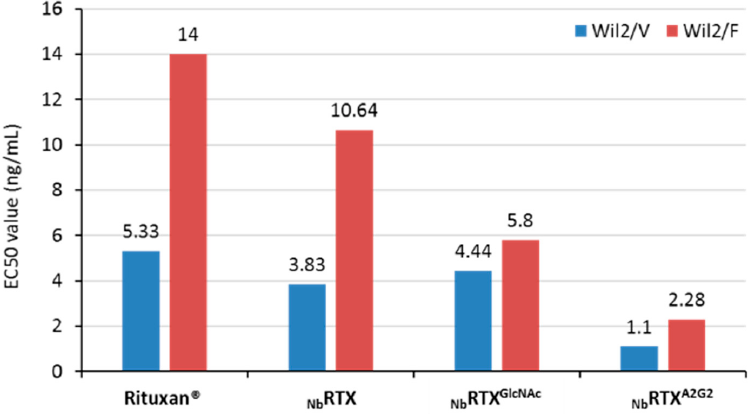
Figure 6. Comparison of EC50 values of Rituxan ® , plant-made rituximab ( Nb RTX), deglycosylated plant-made rituximab ( Nb RTX GlcNAc ), and reglycosylated plant-made rituximab ( Nb RTX A2G2 ) determined by the ADCC Reporter Bioassay using Wil2 V/V158 (Wil2/V) and F/F158 (Wil2/F) variant cells. The calculated EC50 values are shown above the respective histogram bars.